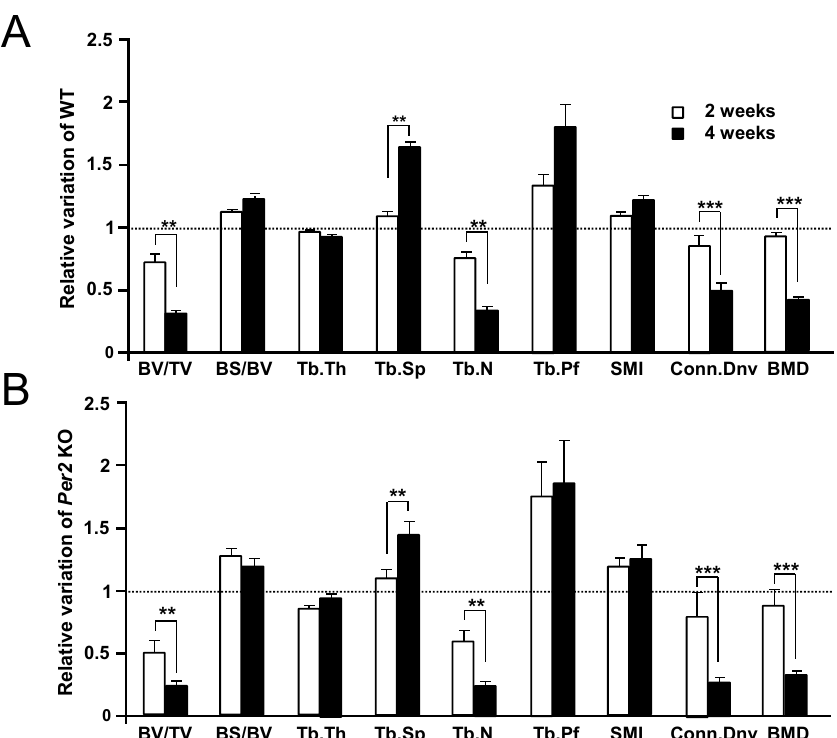
Figure 1. Structural parameters in 405 nm LLLT using MILNS in WT ( A ) and Per2 KO mice ( B ), respectively. Trabecular bone parameters measured with micro-CT and depicted as a histogram. Dotted line indicates relative variation at the start of LLLT using MILNS. The tibia was directly irradiated with LLLT using the MILNS (405 nm, 5 mW, 3 J/cm 2 , 600 s). Mice were irradiated five days/week for four weeks. At two and four weeks after laser irradiation, BV/TV (%), Tb.Th (mm), Tb.Sp (mm), Tb.N (mm − 1 ), Tb.Pf (mm − 1 ), SMI, Conn.Dn (mm − 3 ), and BMD (g/cm 3 ) were measured from two-dimensional images obtained using CT-AN 1.8. Data are expressed as mean ± SEM ( n = 9) at each point and were subjected to statistical analysis, ** p < 0.01; *** p < 0.001. LLLT: Low-level laser